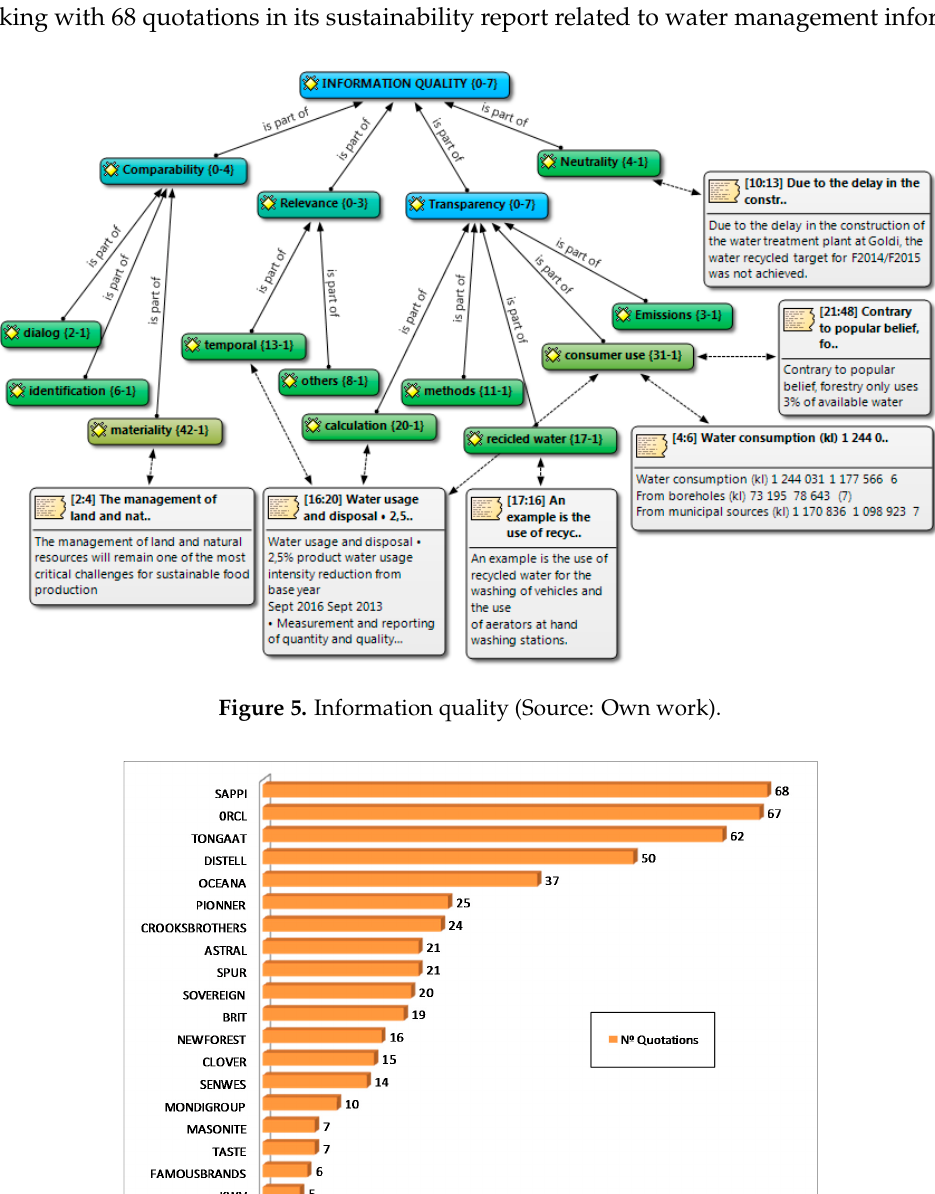
Figure 4. Information quantity (Source: Own work).